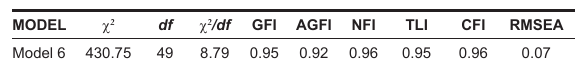
TABLE 3 Goodness-of-fit statistics for the adapted four-factor PEQ model